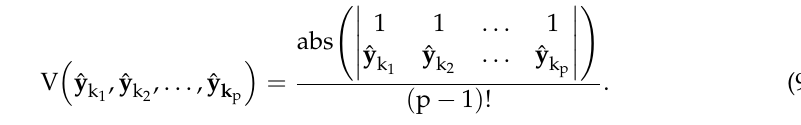
( b ) Figure 3. ( a ) Pseudo-color image of Jasper Ridge; ( b ) spectral signatures of endmembers in Jasper Ridge. 3.1.3. Cuprite Dataset Cuprite is one of the most widely used hyperspectral data for hyperspectral unmix- ing, which contains 224 bands ranging from 370 nm to 2480 nm. The noised bands (1–2 and 221–224) and the water absorption bands (104–113 and 148–167) are removed, and 188 bands are retained. A sub-image of 250 × 190 pixels is utilized in our experiments,